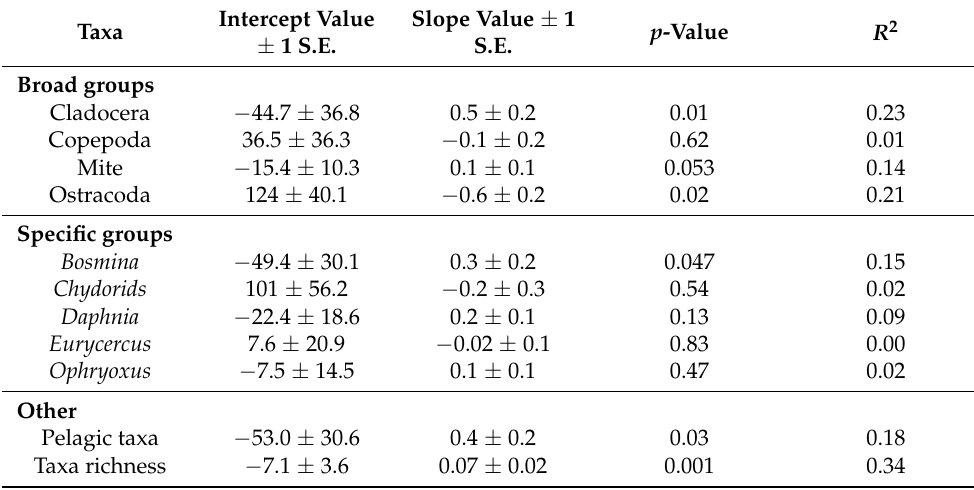
Table 1. Simple linear regression model statistics between the percent dominance in density of different zooplankton groups in traps and Julian day; n = 27 for all